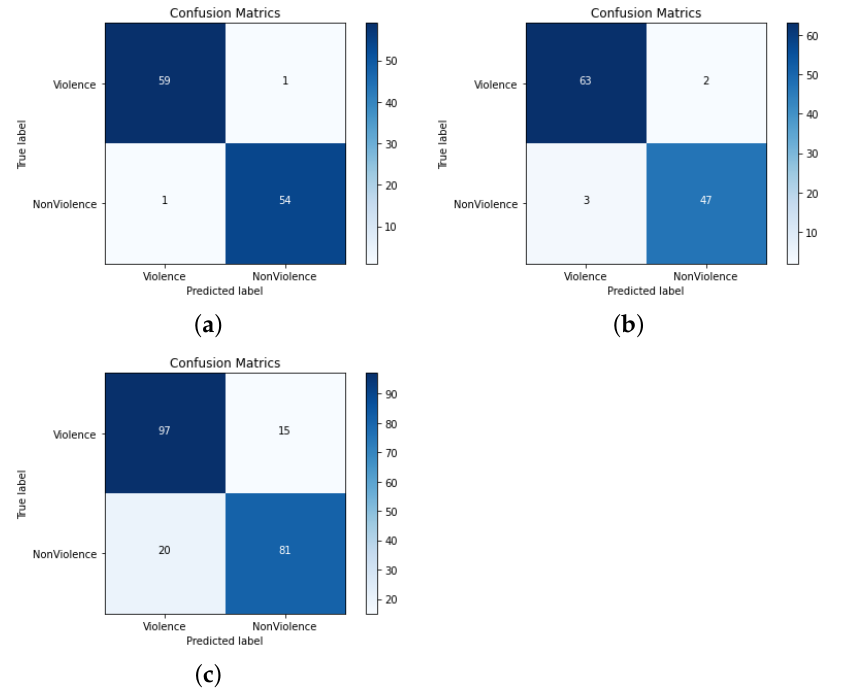
Figure 8. Performance analysis of the proposed model using standard VD datasets (zoom in for better visibility). ( a ) Peliculas; ( b ) Violence in movies; ( c ) Industrial surveillance